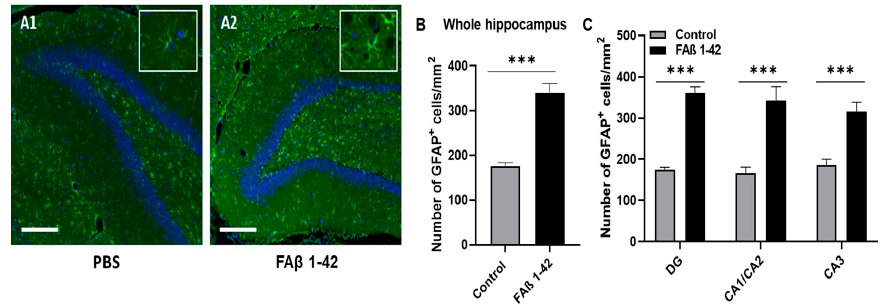
Figure 2. Quantification of GFAP + astrocytes in the hippocampal areas. Brain sections from rats infused with FA β 1–42 (1 µ g/ µ L) or PBS solutions were analyzed 14 days post-injection. ( A1 , A2 ) Representative immunohistochemical staining of GFAP expression (in green) in the DG area. The slides were counterstained with DAPI (blue). Scale bar, 500 µ m. The box corresponds to GFAP staining with a higher magnification ( B ) Histograms showing the number of GFAP + cells per mm 2 quantified in the total hippocampus and ( C ) in each area of the hippocampus (CA1/CA2, CA3 and DG). The quantification of GFAP + cells was analyzed in 4–5 sections per animal ( n = 5 for each group). Statistical comparisons between both groups were analyzed using a Student’s t -test. *** p ≤ 0.001.